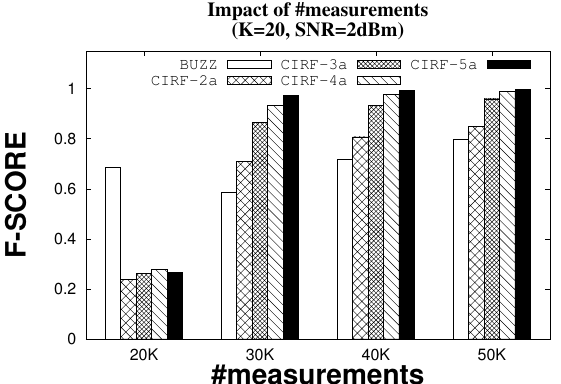
Figure 5. F-score with varying number of measurements ( × K ).